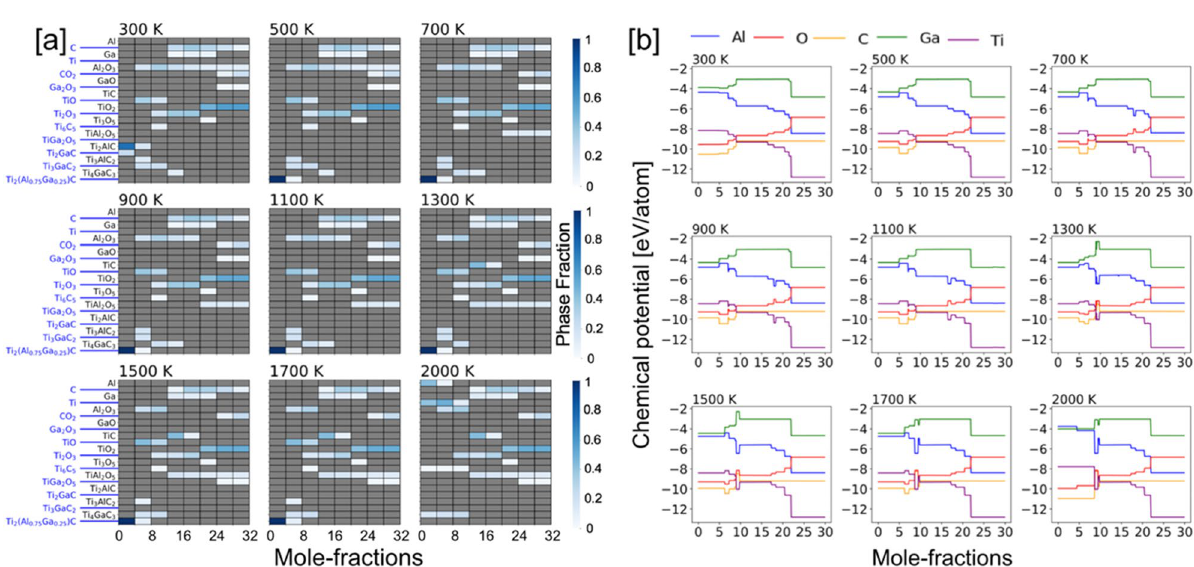
Figure 7. ( a ) Phase fractions and ( b ) chemical potential of [Ti 2 (Al 0.75 Ga 0.25 )C + O 2 ] with increasing temperature from 300 to 2000 K and molar percent oxygen (0–32 mol). The color gradient (shades of blue) shows molar phase fractions. Blank spot [gray (0)] suggests no phases. On oxidation, the partial chemical potentials of Ti/Al/ Ga/C reduce while the chemical potential of invading O 2